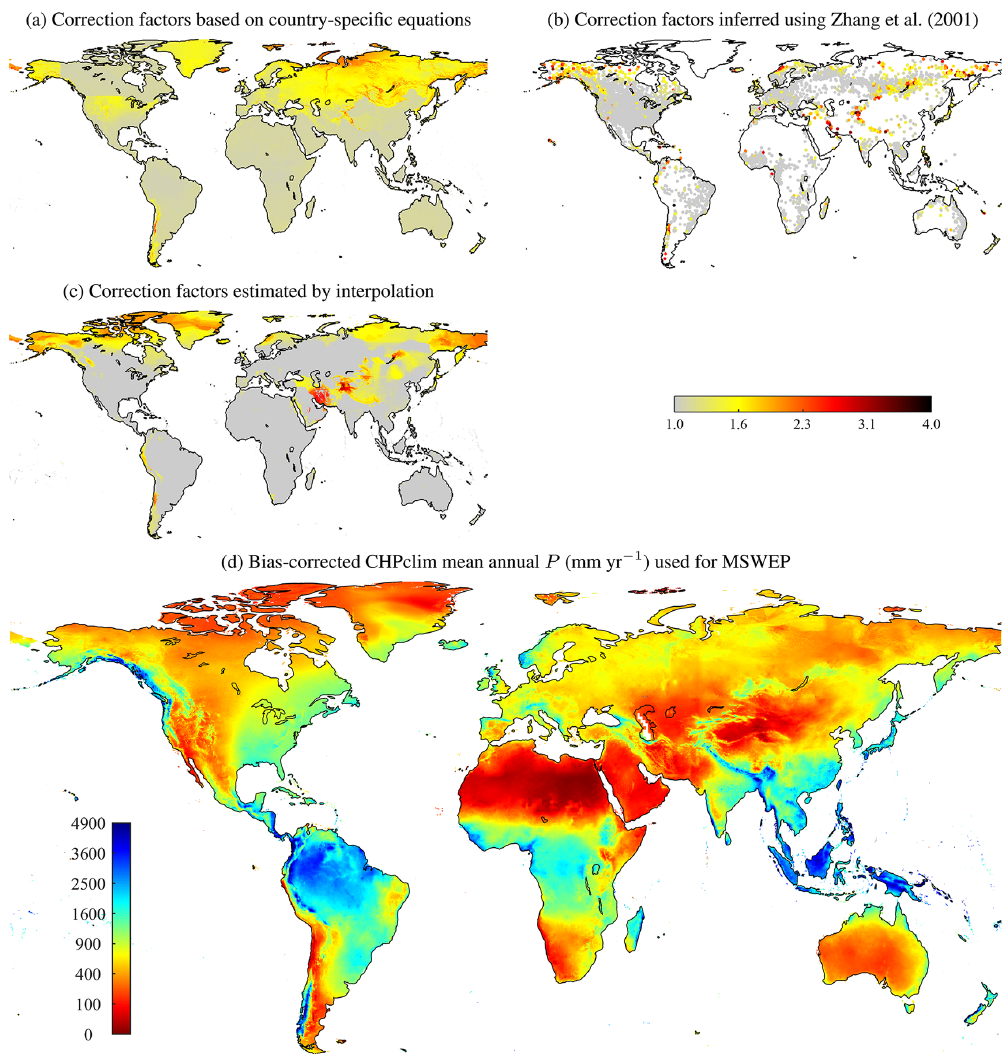
Figure 2. Global maps of (a) bias correction factors estimated using country-specific equations, (b) bias correction factors inferred using the Zhang et al. (2001) relationship from Q observations and E p estimates, (c) bias correction factors computed by interpolating the Zhang et al. (2001)-based values, and (d) mean annual P (mmyr − 1 ) from CHPclim bias-adjusted using the interpolated bias correction factors and used for MSWEP. The data points in (b) represent the centroids of the catchments ( n = 12493) and the interstation regions ( n = 1651). Note that there are many values in (b) < 1, but these are not of interest here and thus are shown as